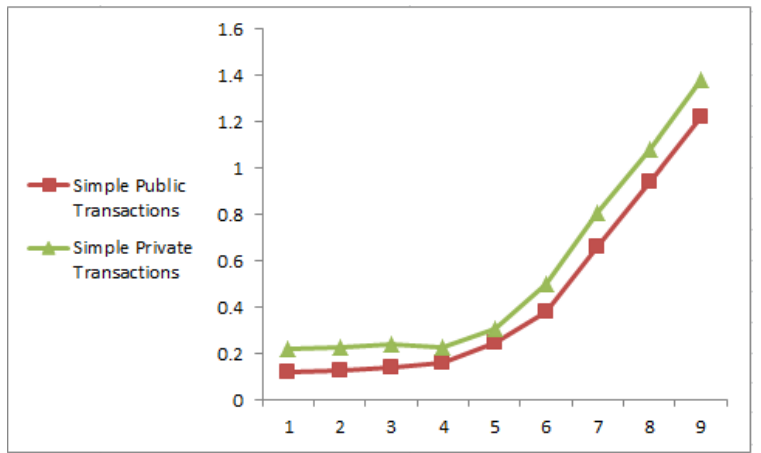
Figure 23. Latency at low throughput vs. block